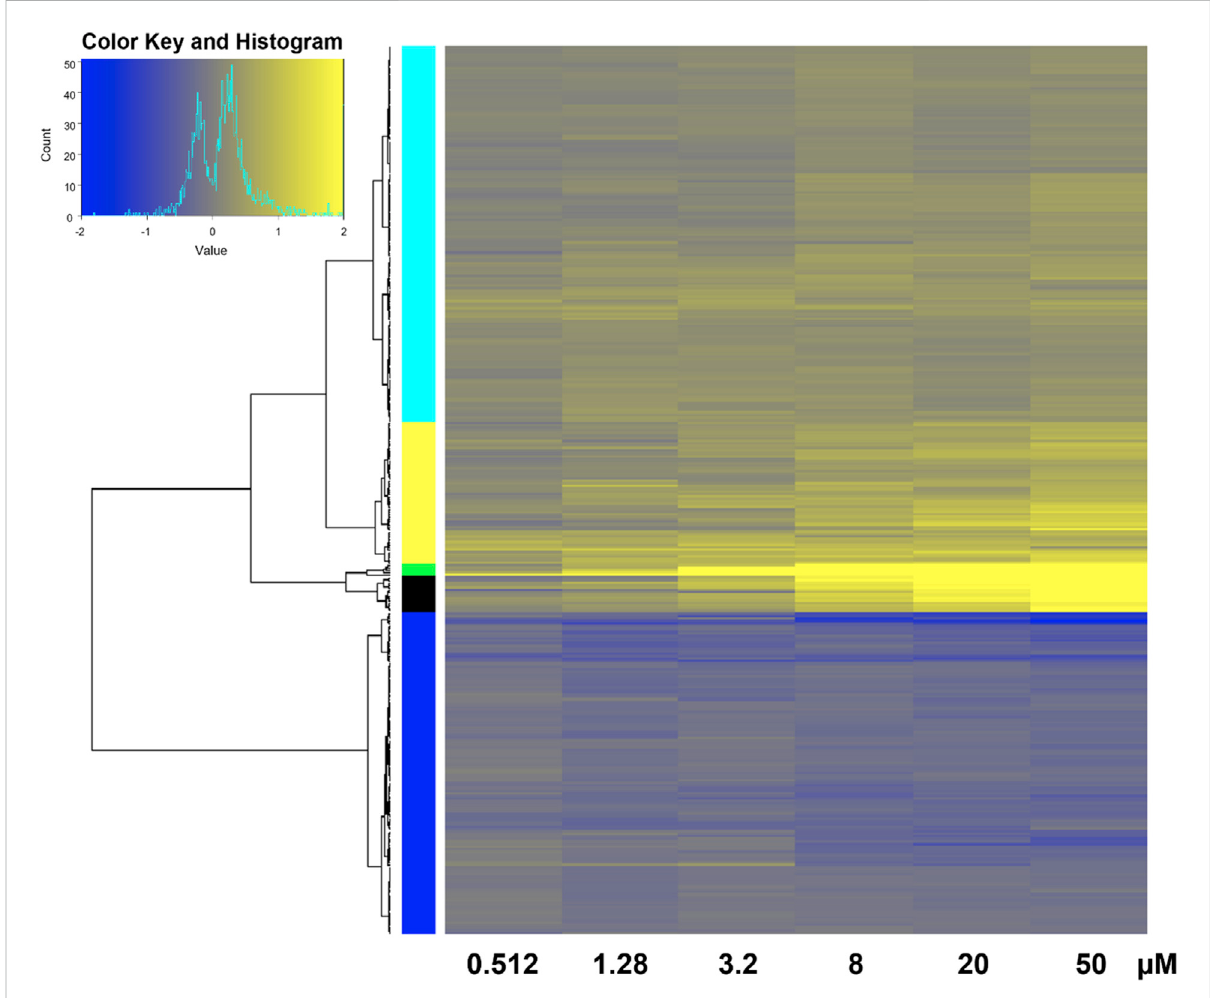
FIGURE 4 Heatmap of transcriptomic response at each retene concentration for genes common to both non-teratogenic and teratogenic concentrations. Average Log2FC values for each gene at each treatment are displayed with yellow indicating higher expression and blue indicating lower expression compared to DMSO vehicle control. Genes are grouped by ward clustering with gene clusters on the